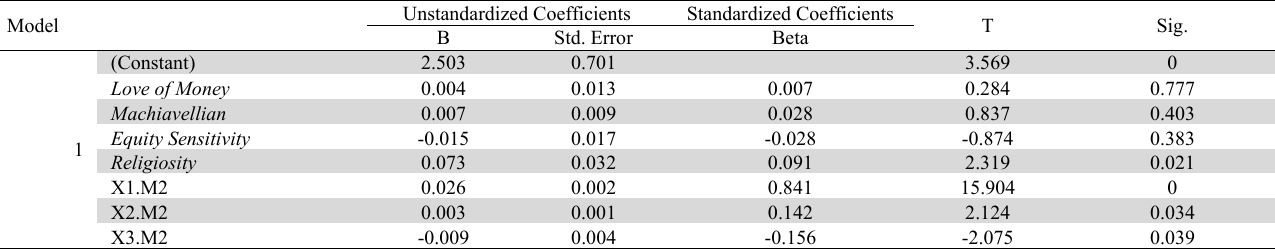
Results of Extrinsic Religiosity Moderation Regression